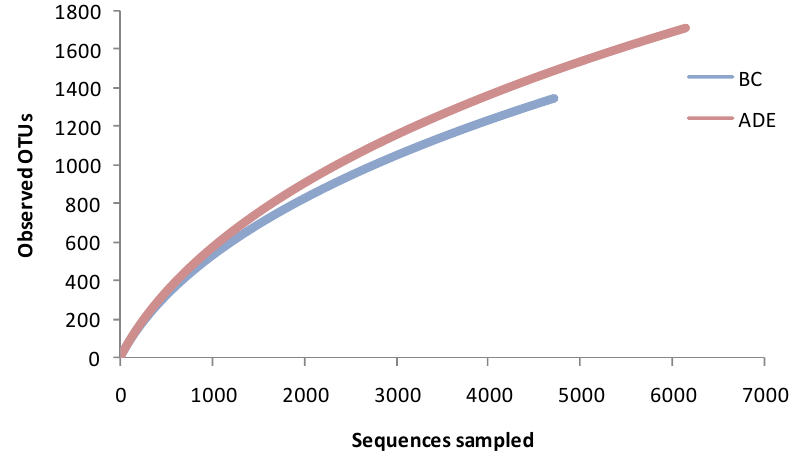
Figure 5. Rarefaction curves of the Amazonian Dark Earth (ADE) and black carbon (BC). Sequences were obtained by pyrosequencing the bacterial 16S rRNA gene pool from the ADE site at Hatahara in the Central